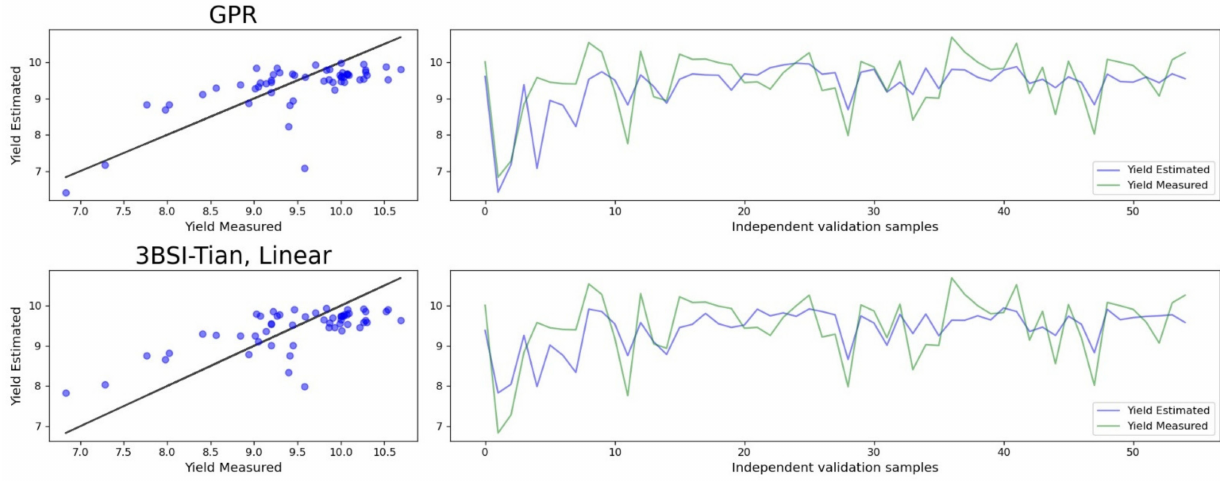
Figure 7. Relationship between observed and predicted GY. The predicted GY is from the best per- forming nonparametric (GPR) and parametric (3BSI-Tian, linear) models in grain filling phenophase. The black line is 1:1